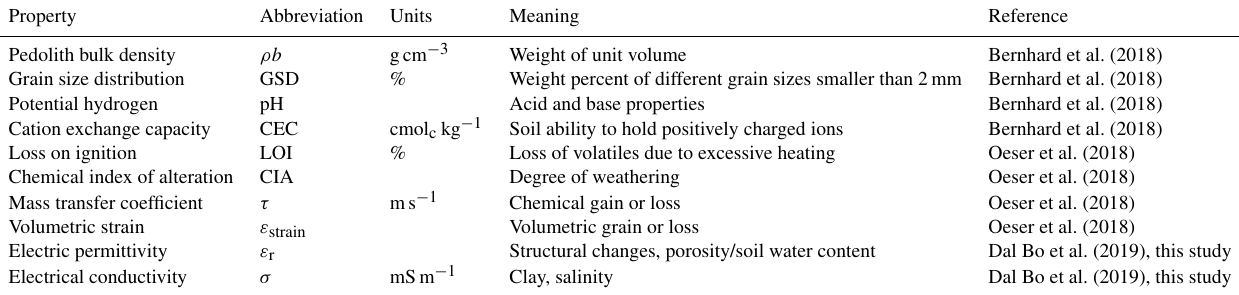
Figure 4. Compilation of physical and chemical investigations with depth at the pedon location in the mid-slope position of the S-facing hillslope in Pan de Azúcar. Properties shown are (1) GPR transect and the envelope profile of the 500MHz measurement; (2) GPR transect and the envelope profile of the 1000MHz measurement; (3) bulk density; (4) grain size distribution of sand, silt, and clay; (5) loss on ignition, LOI; (6) chemical index of alteration, CIA; (7) chemical index of the mass transfer coefficient τ ; and (8) volumetric strain ε strain . The black line indicates the boundary between the mobile pedolith and the immobile saprolith (after Oeser et al., 2018), and the gray area with green lines reflects the transition zone from B to C horizon (after Bernhard et al., 2018). Table 2. Overview of physical, chemical, and geophysical properties determined in the four different study areas. Property